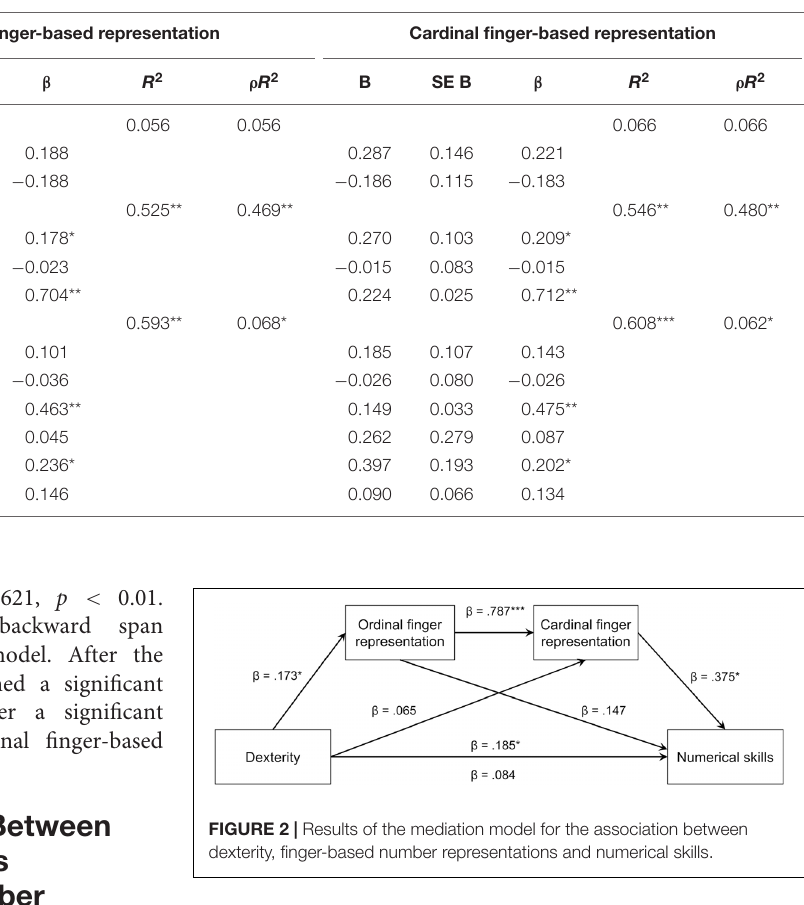
total effect of children’s finger dexterity on numerical skills, β = 0.185, SE = 0.077, p < 0.05, was mediated by their finger- based representations as indicated by a significantly